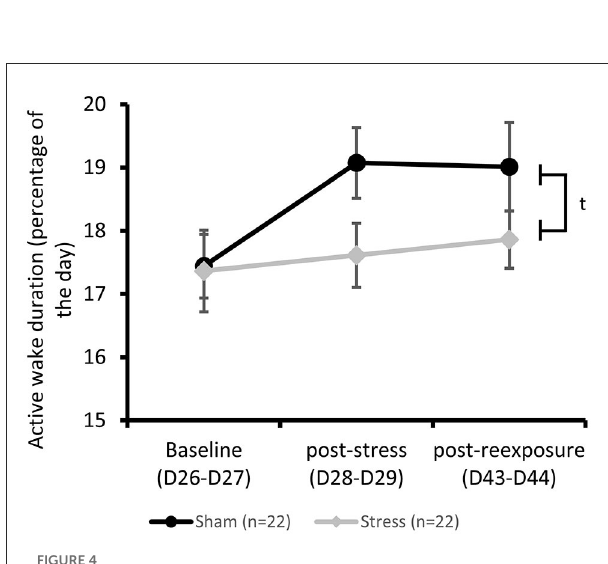
FIGURE4 Active wake characterization: Active wake duration measured by telemetry. ANOVA for repeated measures, group effect: t p < 0.10. Results are expressed as mean ±